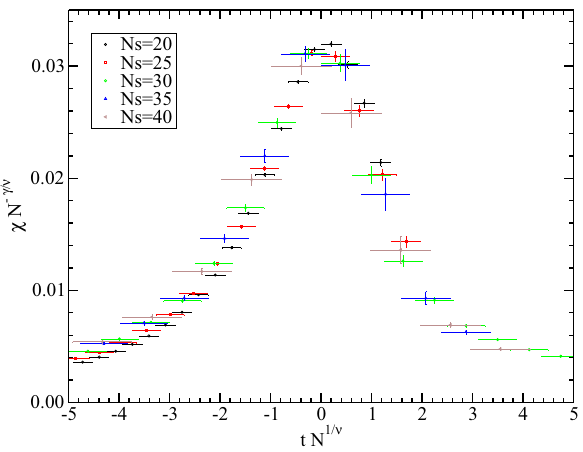
Fig. 14 Trace anomaly normalised to the SB limit of the pressure